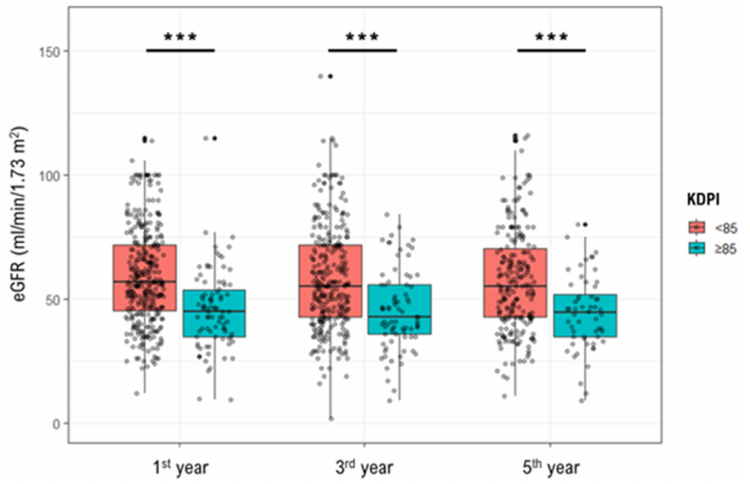
Figure 2. Boxplots depicting the effects of high KDPI on renal function at the 1st, 3rd, and 5th post-transplant year. KDPI ≥ 85 was associated with a significantly lower estimated glomerular filtration rate. *** p - value < 0.001.